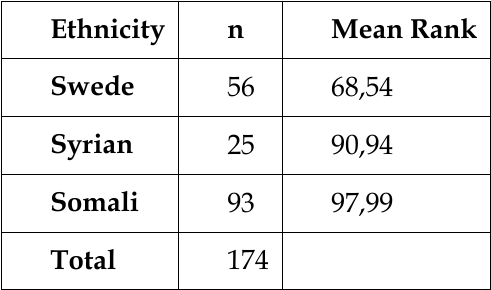
Table 27. Willingness to use the Digital Health Centre and ethnicity. Kruskal-Wallis mean